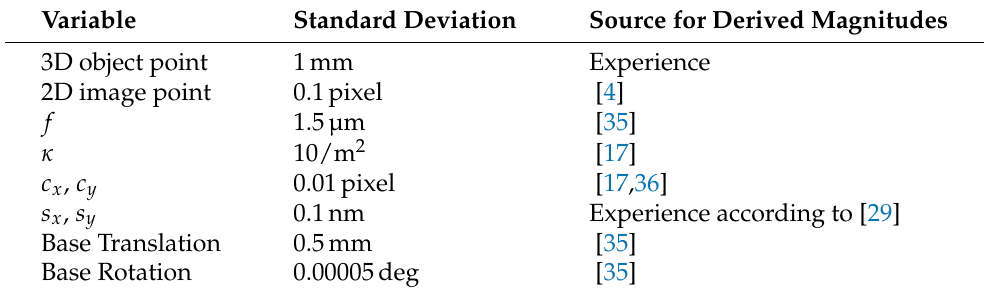
Figure 6. Activity diagram of the Monte Carlo simulation for accuracy estimation of the overall system using the example of the stereo camera system. Table 1. Standard deviations of normal distributed influencing factors in the Monte Carlo